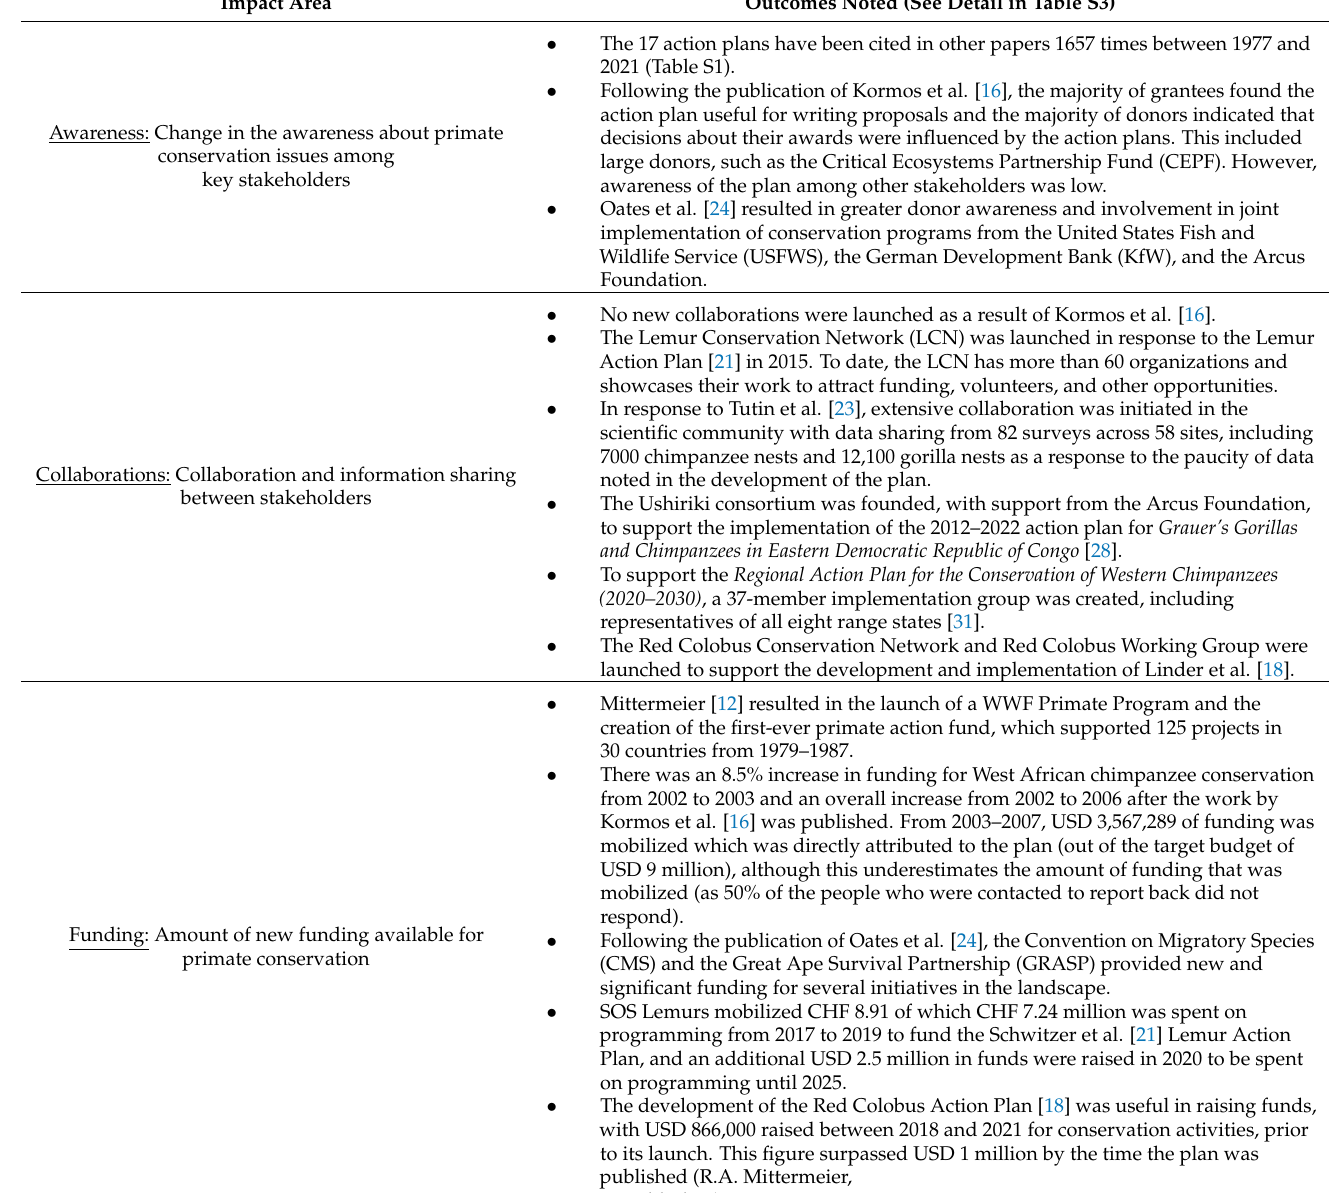
Table 2. Summary of outcomes attributed to IUCN SSC PSG primate action plans for which infor- mation about post-publication implementation was available (see Table S3 for further information). Framework adapted from